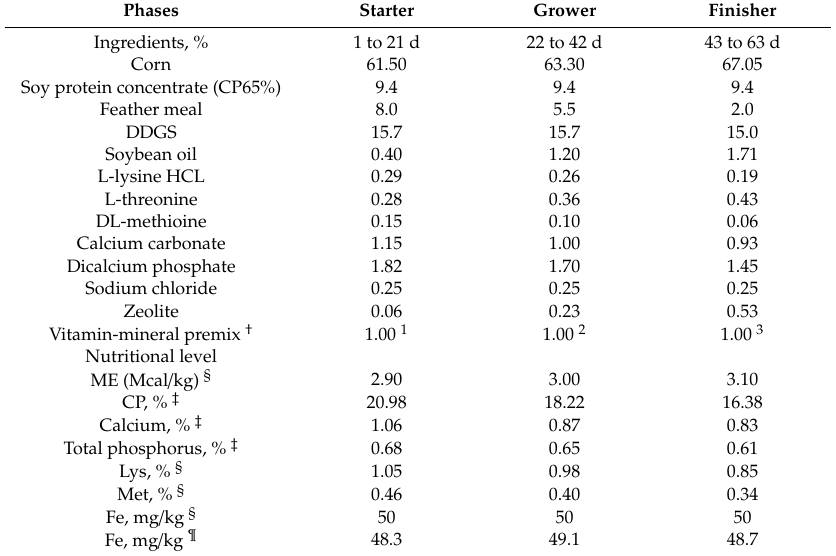
Table 1. Composition and nutrient level of the basal diet for three experiments (as fed-basis). Phases Starter Grower Finisher Ingredients,